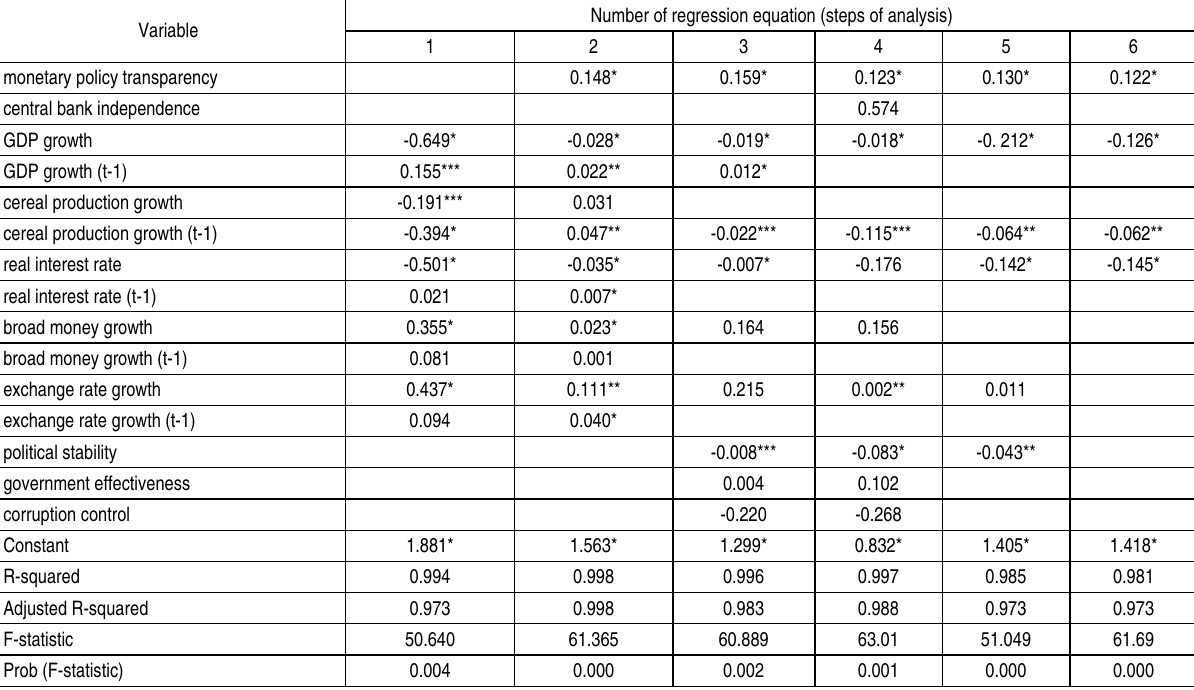
Table 2. Determinants of inflation in Ukraine (static characteristics of multivariate regression equation)